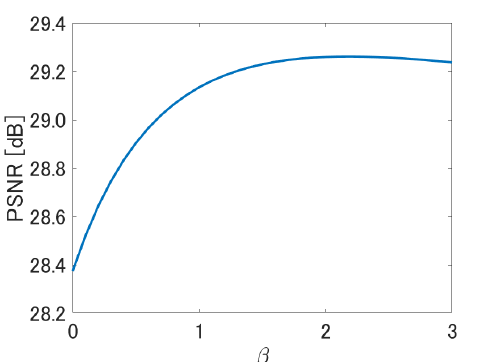
Figure A2. The relation ship between the parameter 𝛽 and the denoising performance of the proposed method when the 𝛽 is applied to ˆ R t 𝑖 t 𝑖 = 𝛽𝜎 2 F 𝑖